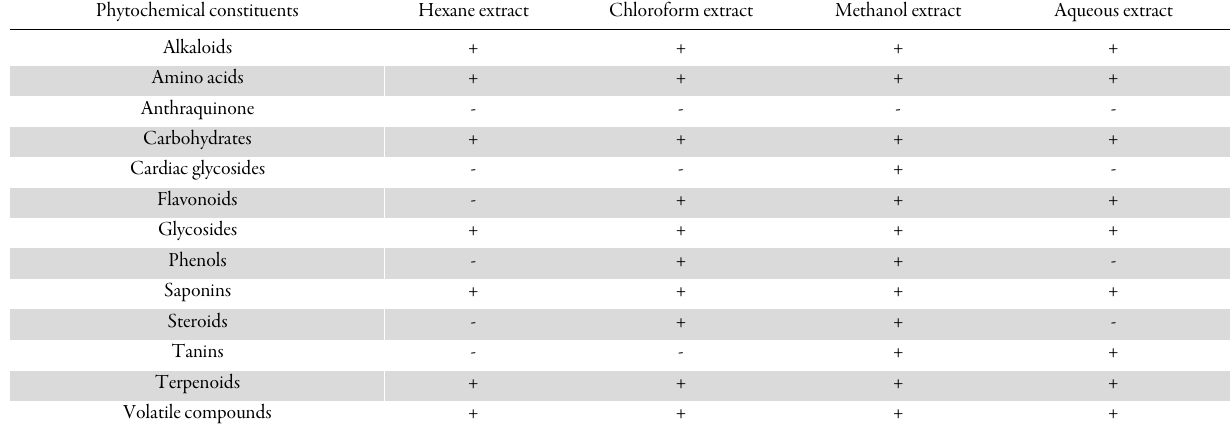
Table 1. Phytochemical constituents of Litsea glutionosa leaves Phytochemical constituents